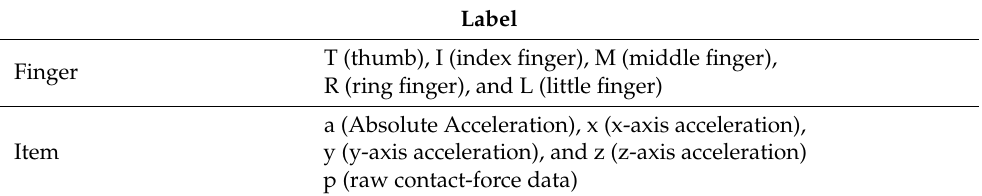
Table 2. The label each item on each finger.